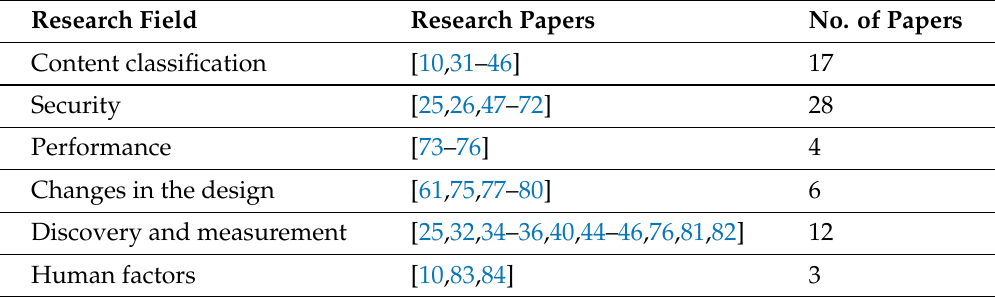
Table 2. Classification of the papers by research